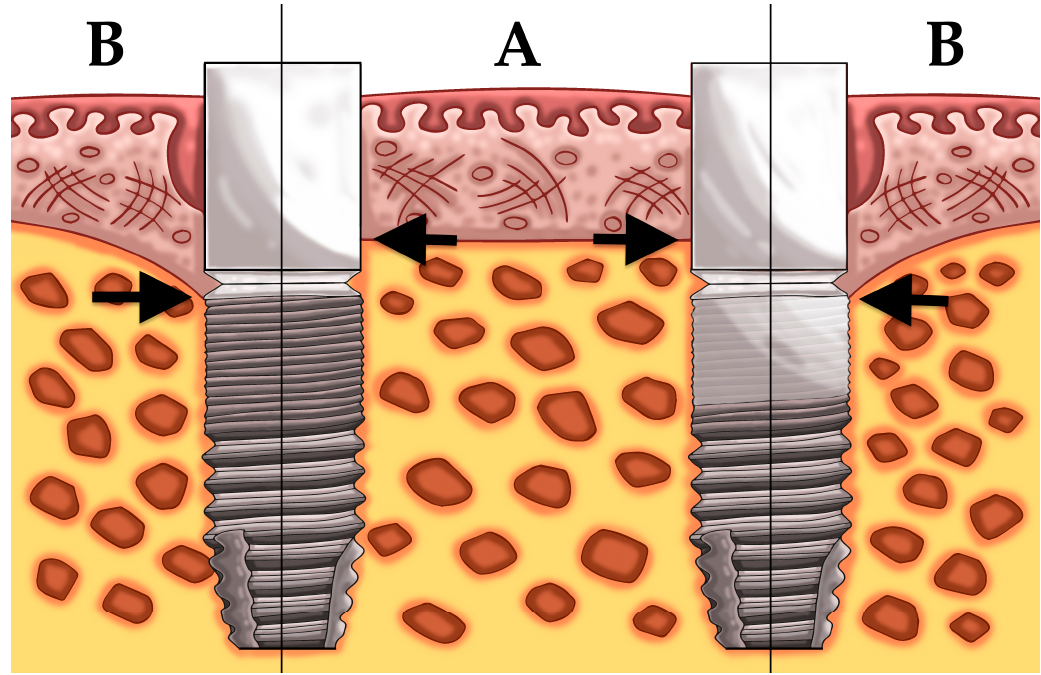
Figure 6. Schematic illustration of study 2 , left implant with a moderately rough neck (group 3) and right implant with a minimally rough neck (group 4); showing the bone level at baseline (A) and bone level after bone remodeling (B).